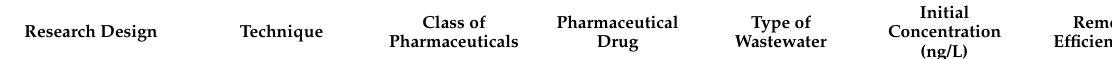
Table 6. Removal of pharmaceuticals by biological treatment